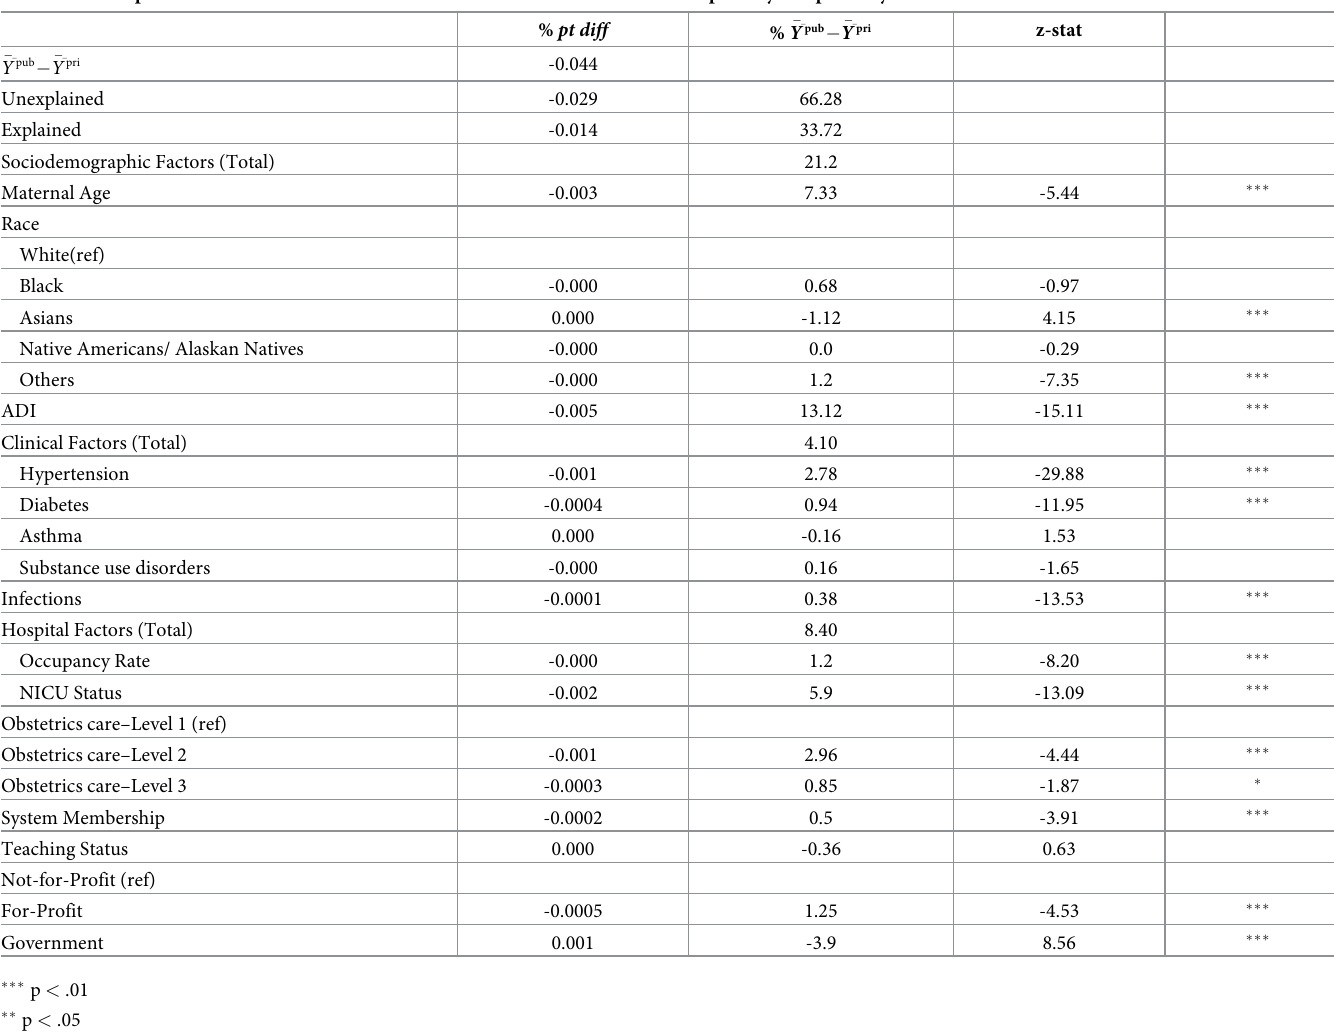
Table 3. Decomposition of the differential in NTSV Low risk C-section rates between publicly and privately insured